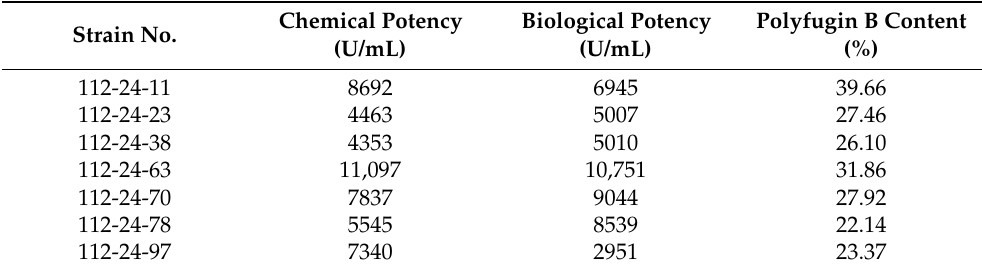
Table 5. Biological potency and Polyfungin B contents of various strains after the third round of UV